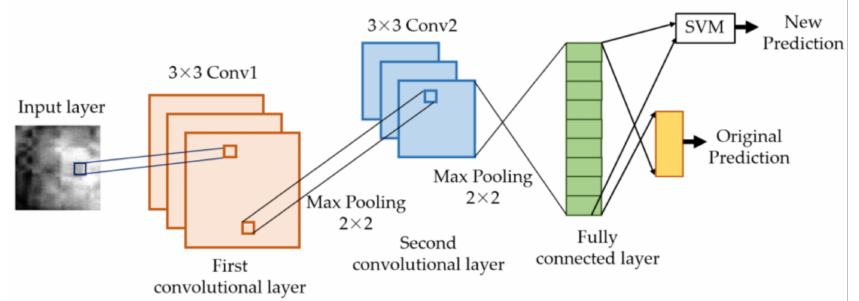
Figure 8. The proposed CNN